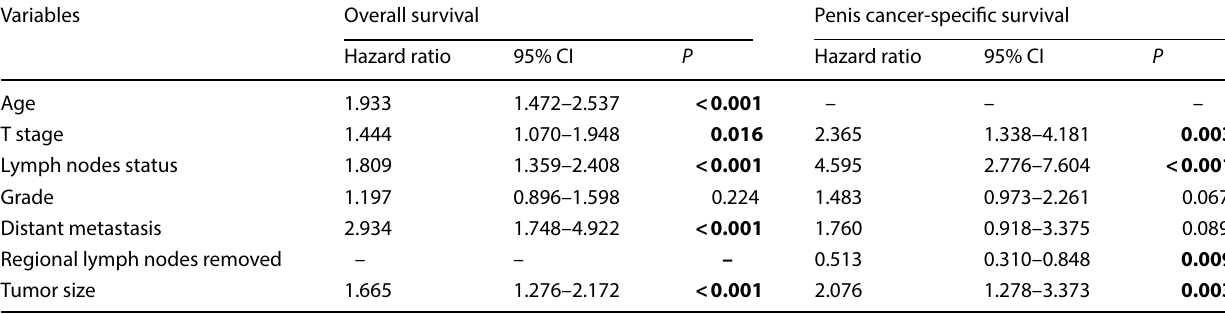
SCCP squamous cell carcinoma of the penis, CI confidence intervals Significant values in bold, “–” =